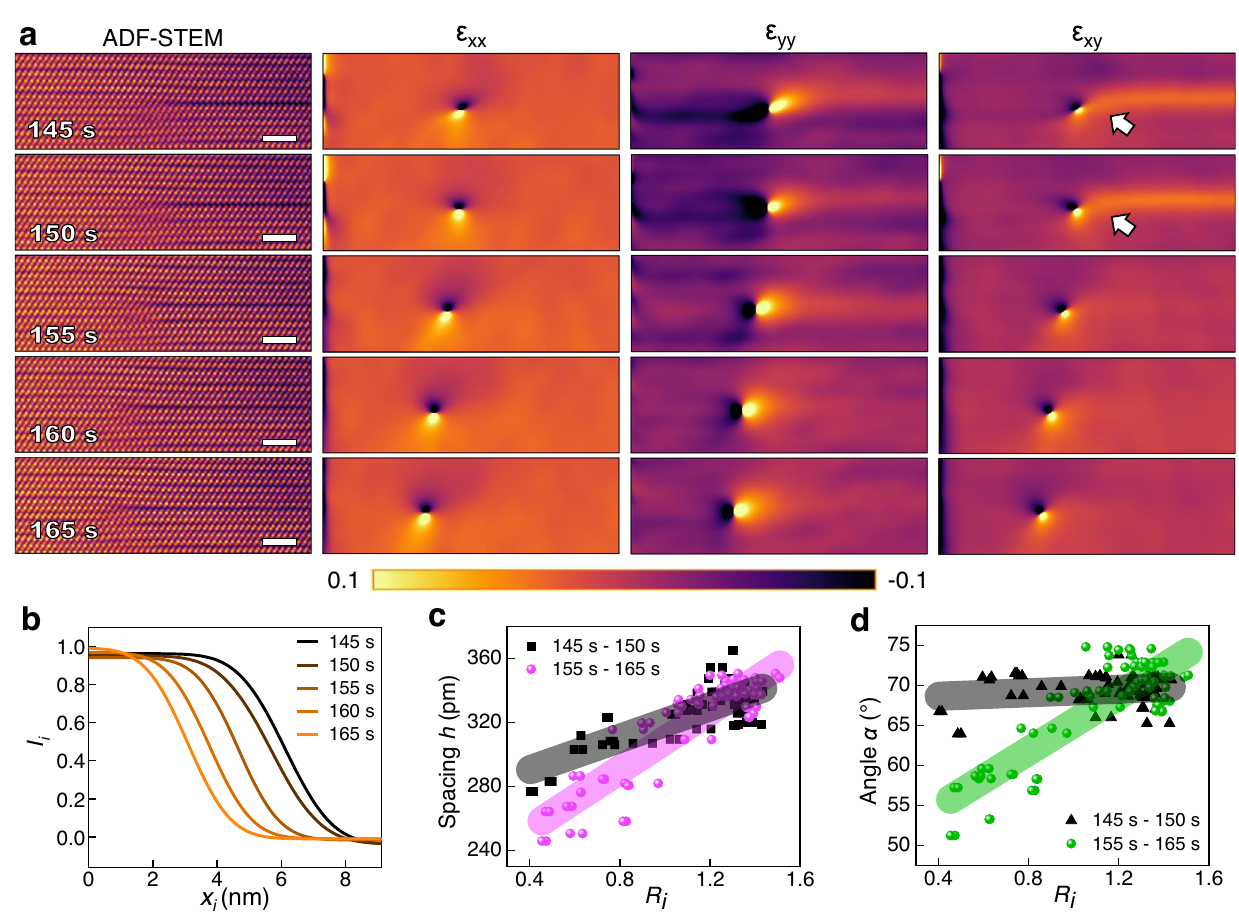
Fig. 3 | Strain and local distortion during cation diffusion. a Geometric phase analysis (GPA) of STEM images acquired from 145 s to 165 s . The locations of the shearingstrainstreakareindicatedbywhitearrows. b Fittingcurvesfromdifferent